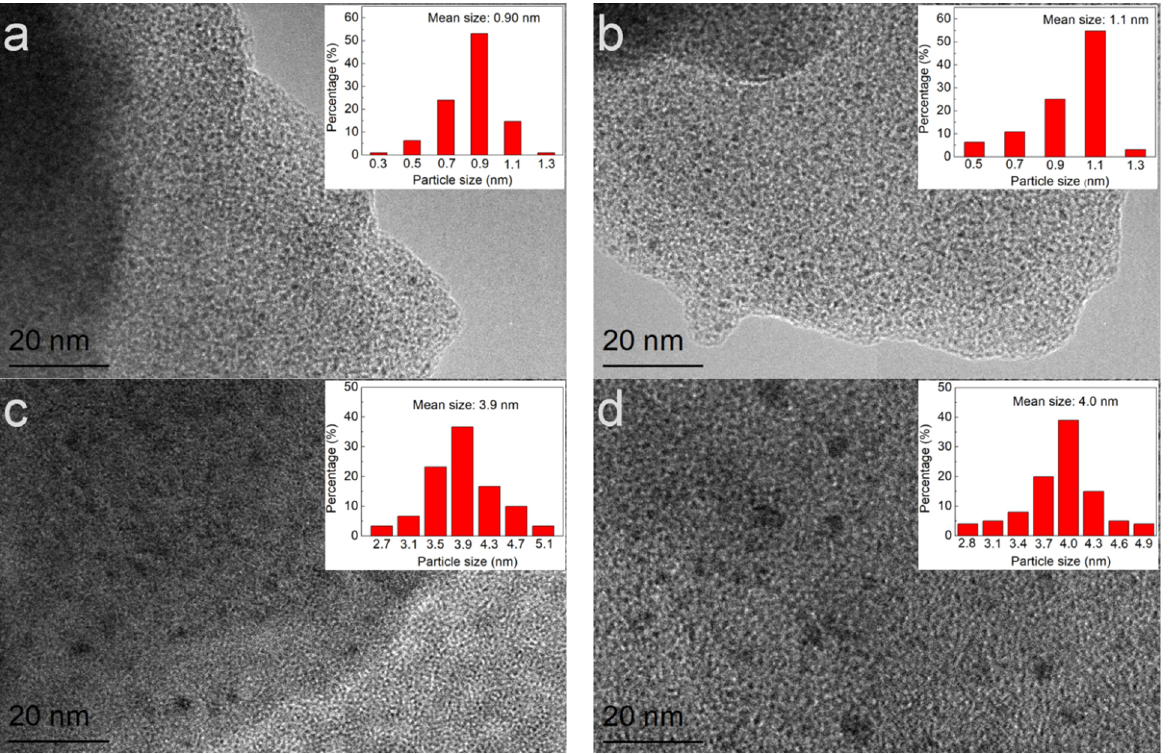
Figure 2. TEM images and particle size distributions of Pd: ( a ) Pd/UiO-66-NO 2 - 7 ; ( b ) Pd/UiO-66- 7 ; ( c ) Pd/UiO-66-NO 2 - 7 (IMP); ( d ) Pd/UiO-66- 7 (IMP).